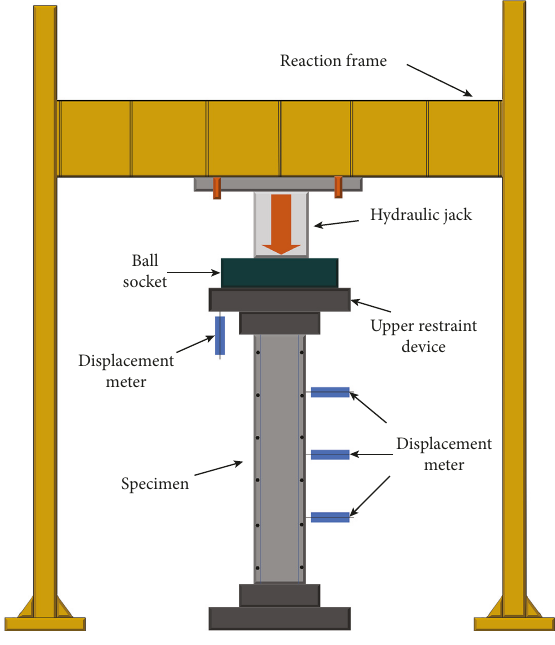
Figure 5: Loading